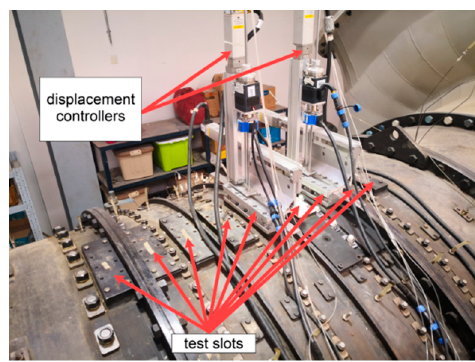
Figure 4. Test slots distribution and the displacement controllers mounted upon.